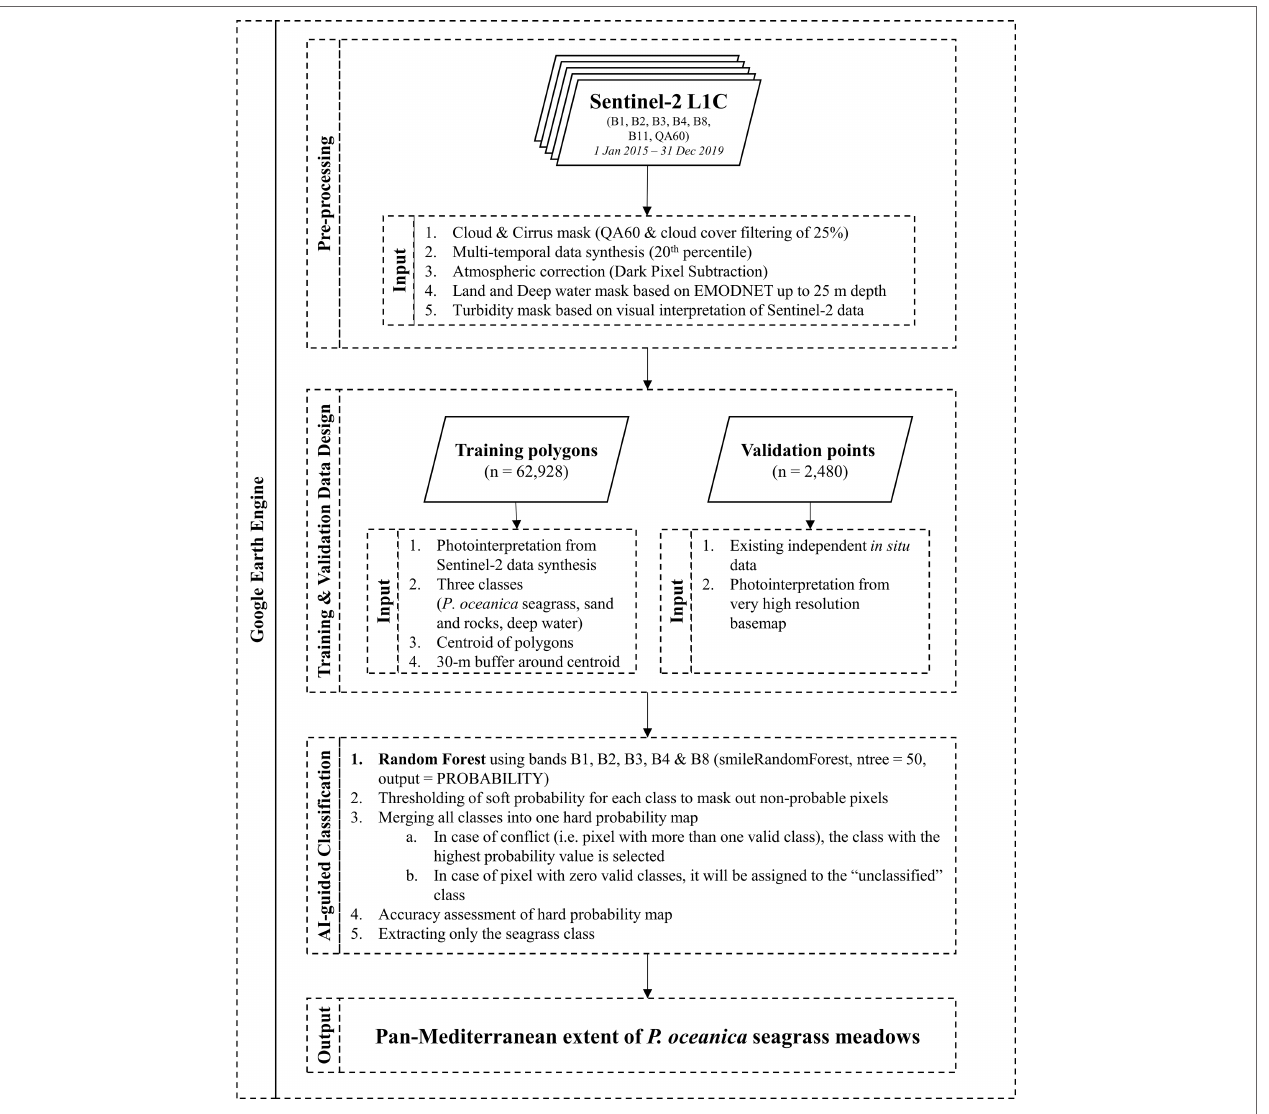
FIGURE 1 | Schematic workflow of our designed and utilized cloud-native Earth Observation